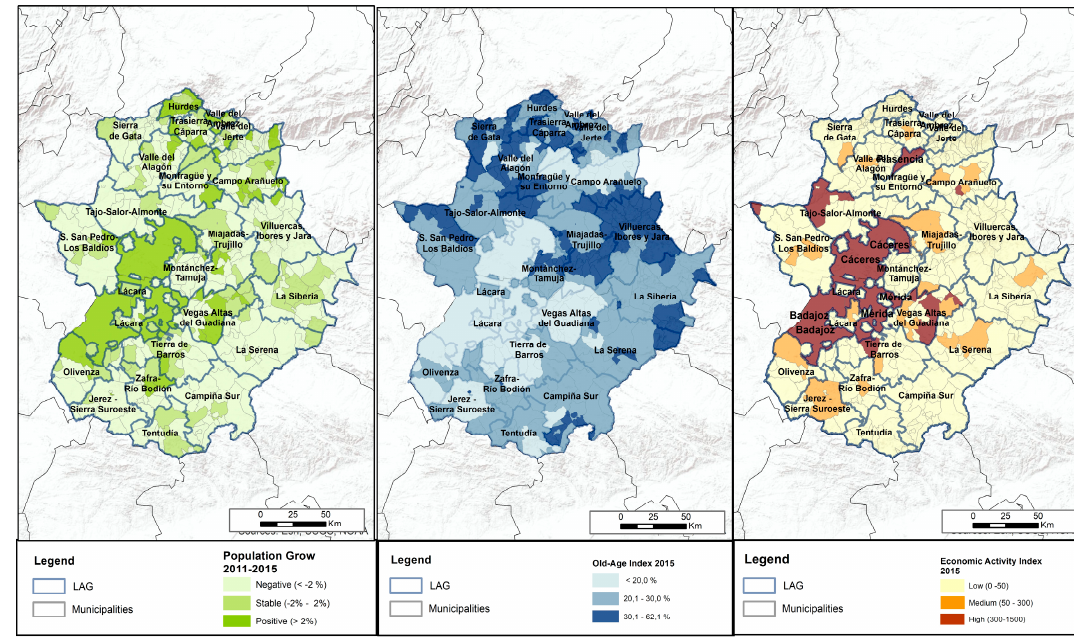
Figure 8. Demographic and Economic indicators of Extremadura (2011–2015).